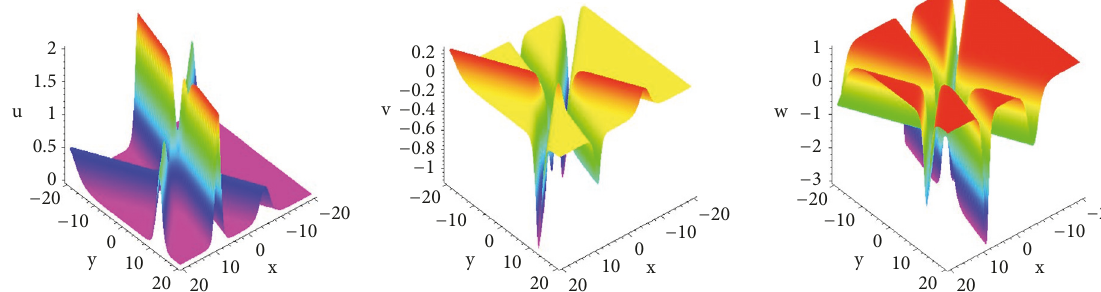
Figure 3: Three interactions of three-resonant solitons expressed by (30) for the solution of (2) and (3) with the parameters 𝛼,𝛽, 𝛾,𝜀, 𝑎, 𝑐